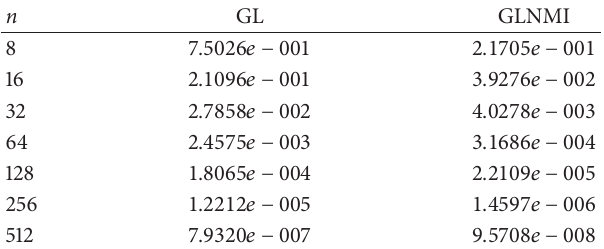
𝜋/3 | sin 30𝑥|𝑑𝑥 . 0